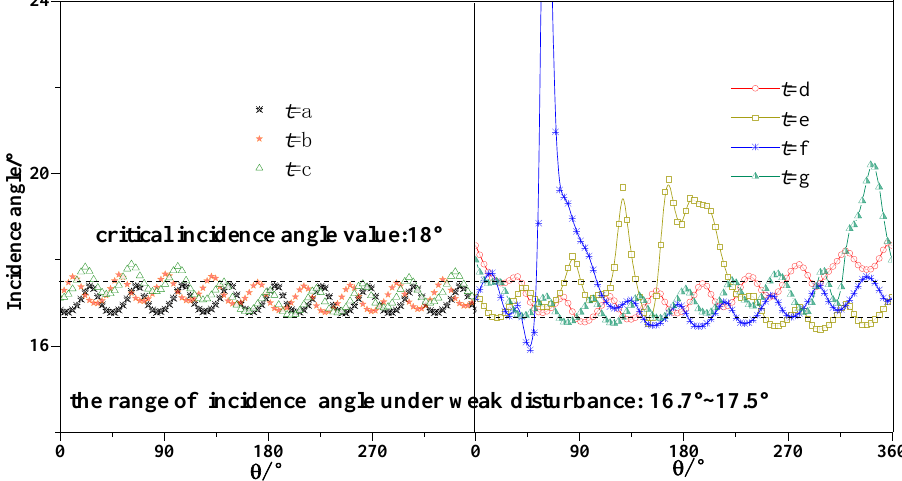
Figure 16. Distribution characteristics of transient incidence angle at 0.8 span.